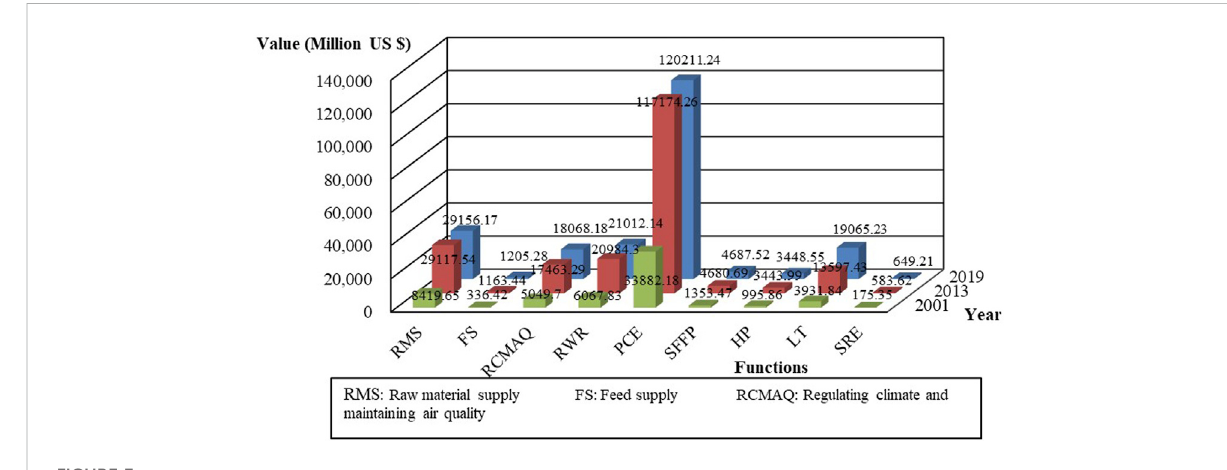
FIGURE 3 Changes of monetary values of mangrove ecosystem services in China in 2001, 2013 and